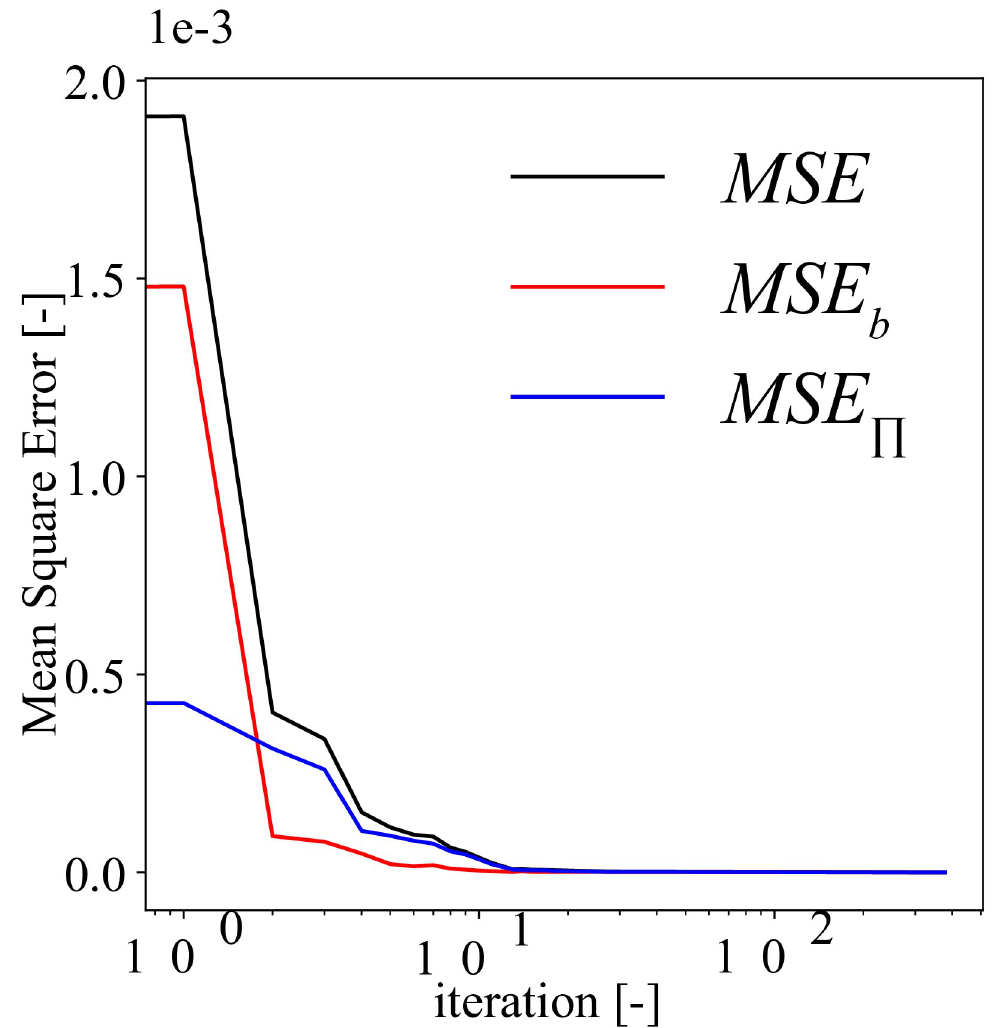
Fig 5. Diffusivity equation—forward modeling: mean square training error plot. This model uses N 96, and N P = 160. MSE , MSE b , and MSE P are calculated using Eqs 28, 29 and 30, respectively.